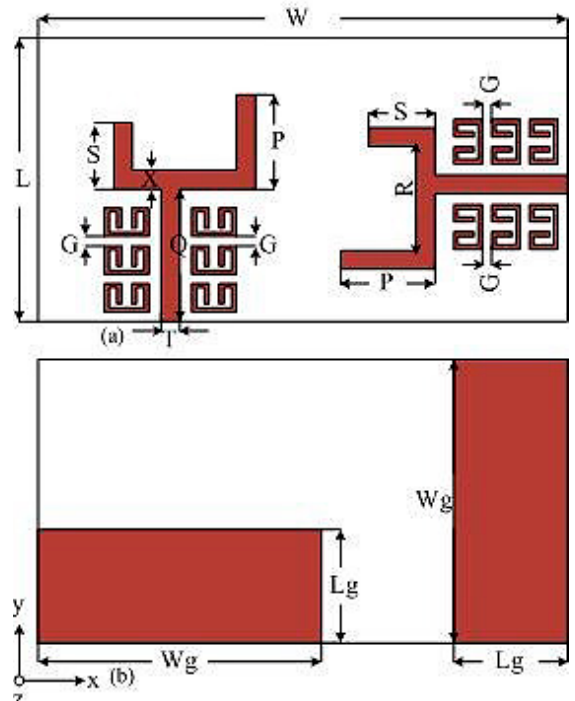
Figure 4. Antenna geometry; top view ( a ), bottom view ( b ).